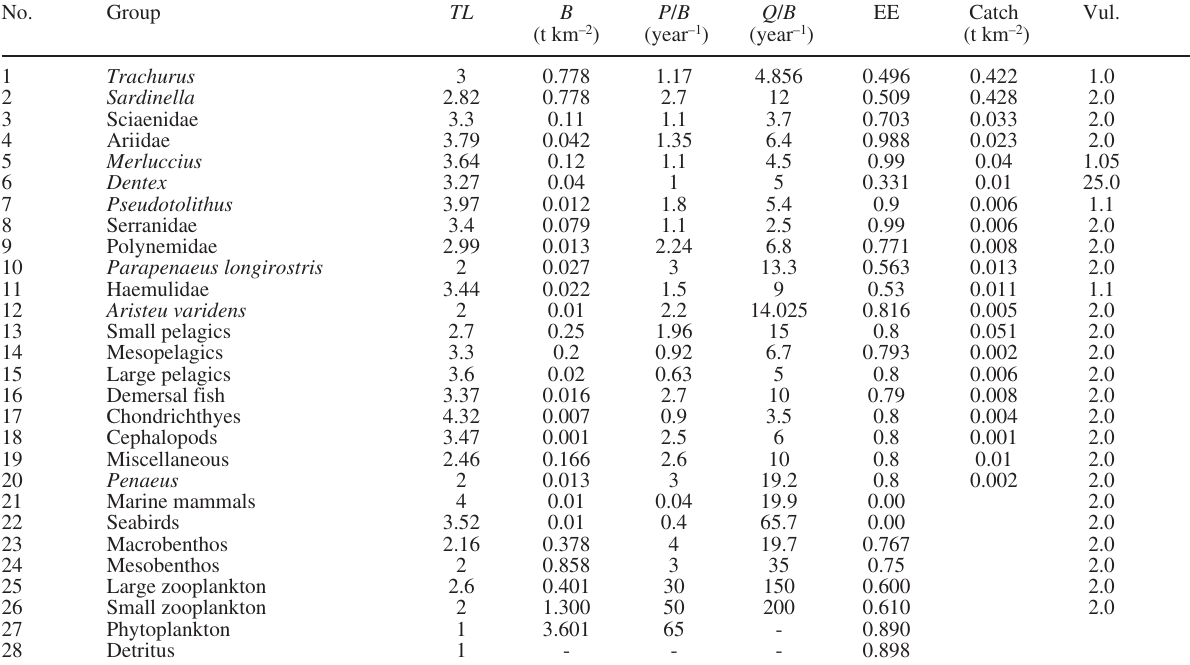
Fig. 2 . – (a) Contributions by different groups to landings (%) in the Angolan fishery; (b) mean trophic level calculated for all species and for species with a trophic level >3.3. Data source: FAO (2000, 2006). Table 1. – Ecopath estimates of the trophic level ( TL ) and ecotrophic efficiency (EE) and the input parameters for the compartments in the ecosystem model of Angola (1986). B , biomass; P / B , production/biomass; Q / B , consumption/biomass; Vul, vulnerability values used in the Ecosim